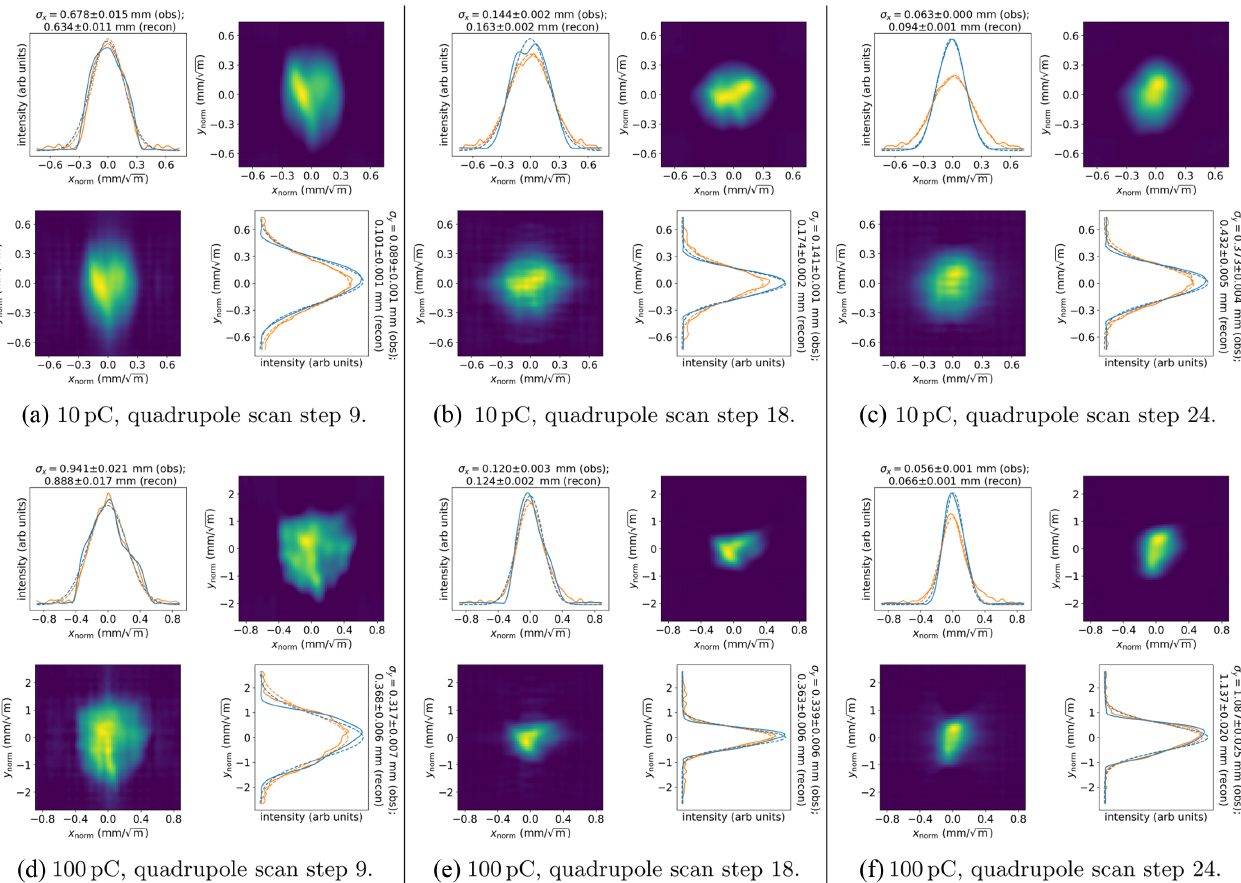
FIG. 4. Validation images from algebraic reconstruction tomography, from three steps in the quadrupole scan at two different bunch charges: 10 pC in cases (a), (b), (c); and 100 pC in cases (d), (e), (f). Within each set of four plots, the top right and bottom left images show (respectively) the observed and reconstructed beam image at the observation point; continuous lines in the top-left and bottom- right plots show the density projected onto (respectively) the horizontal and vertical axes, broken lines show Gaussian fits (used to determine the beam sizes, with values shown alongside the relevant plots). Blue lines correspond to the observed image, and orange lines correspond to the reconstructed image. Note the different scales on the coordinate axes for 10-pC and 100-pC bunch